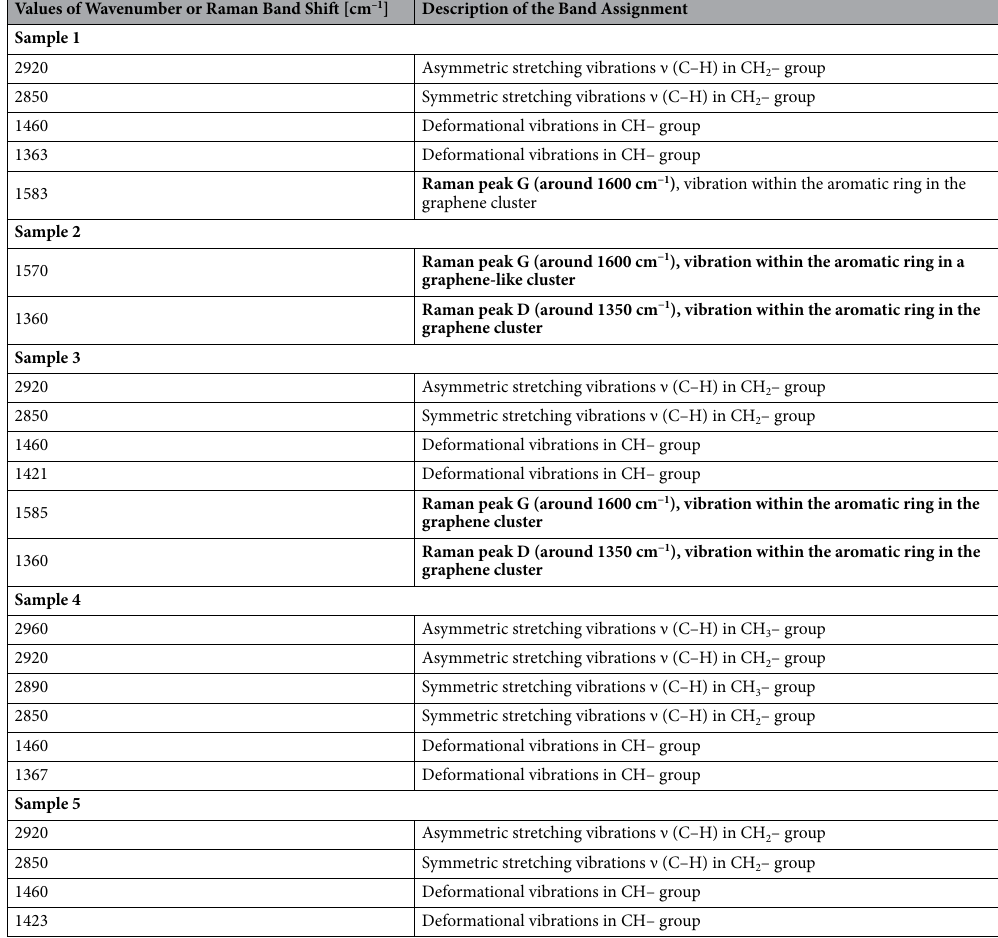
Table 2. Values of wavenumber and Raman shift indicative for the identification of bitumen 32–36 , which were defined in residues on archaeological samples 1–5 on the basis of FTIR and Raman spectroscopy respectively. Raman band assignments are in